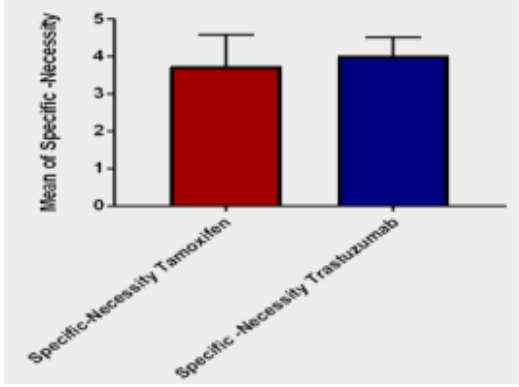
Figure 1. Mean of Specific-Necessity for Tamoxifen and Trastuzumab.